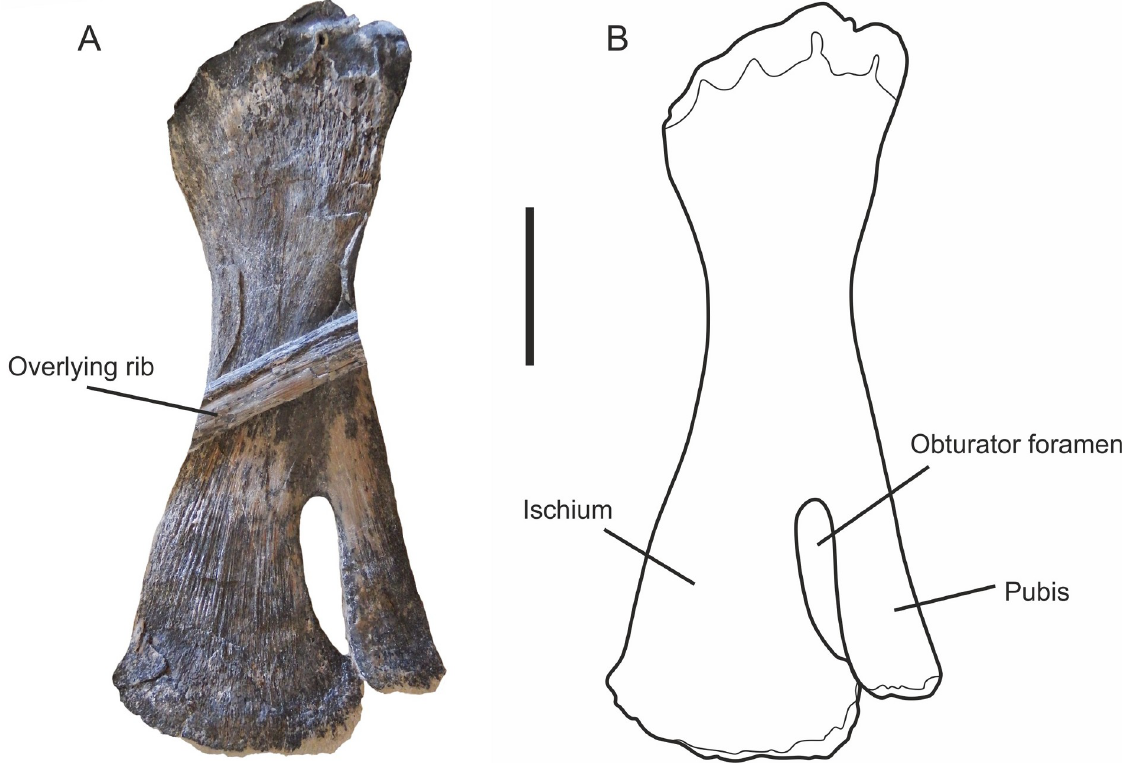
Fig 17. Ischiopubis of Thalassodraco etchesi , MJML K1885. A, photograph of isolated ischiopubis. B, line diagram of ischiopubis. Scale bar 20 mm.